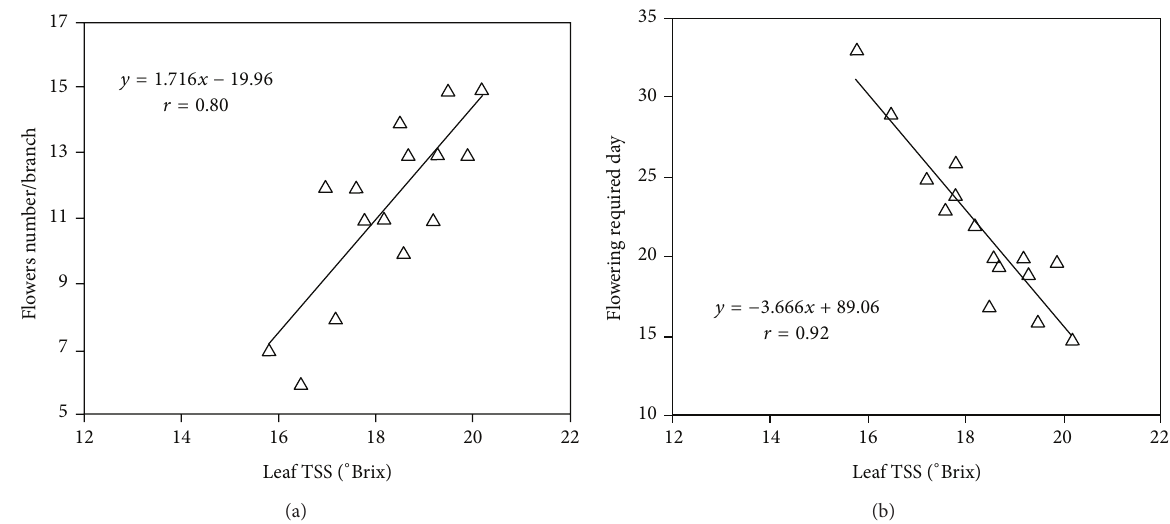
Figure 7: Regression lines for the relationship between flower number and leaf TSS (a) and flowering day and leaf TSS (b) in the treated Bougainvillea